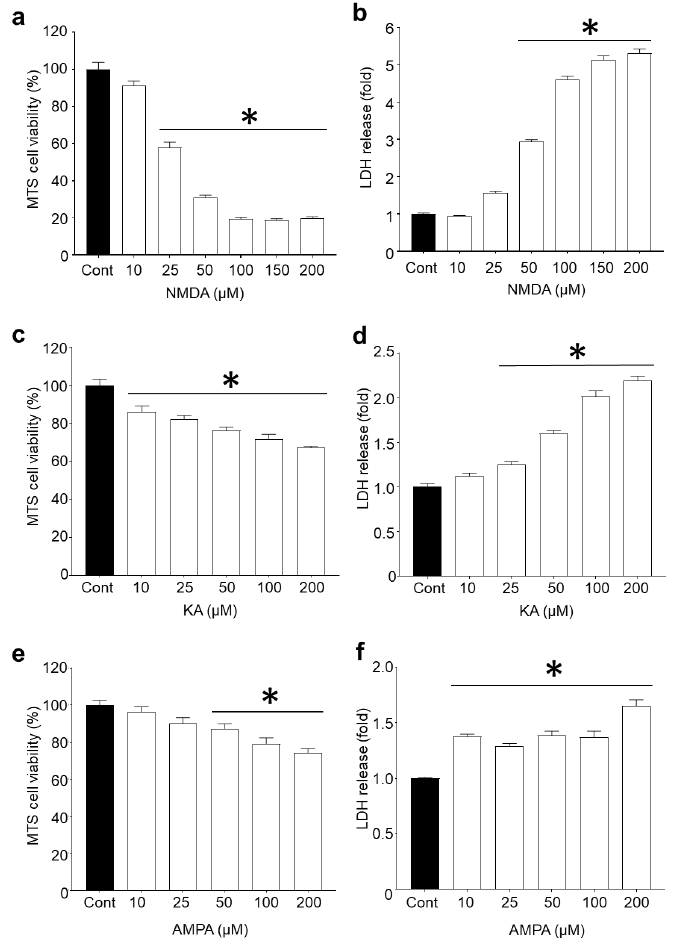
Figure 1. Ionotropic glutamate receptor agonists induce dose-dependent neuronal death at 24 h post-exposure. Dose–response studies of DIV10 primary cortical neurons exposed to ionotropic glutamate receptor agonists (10–200 µM) for 5 min. Neuronal viability and cell death were measured using MTS and LDH assays, respectively, at 24 h post-exposure to ( a, b ) NMDA, ( c, d ) KA, and ( e, f ) AMPA.